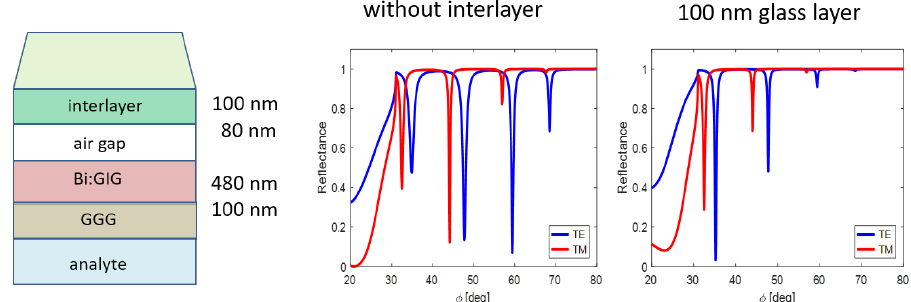
Figure 2. Waveguide resonance states distribution at the angular scale without glass interlayer (centre picture) and with this